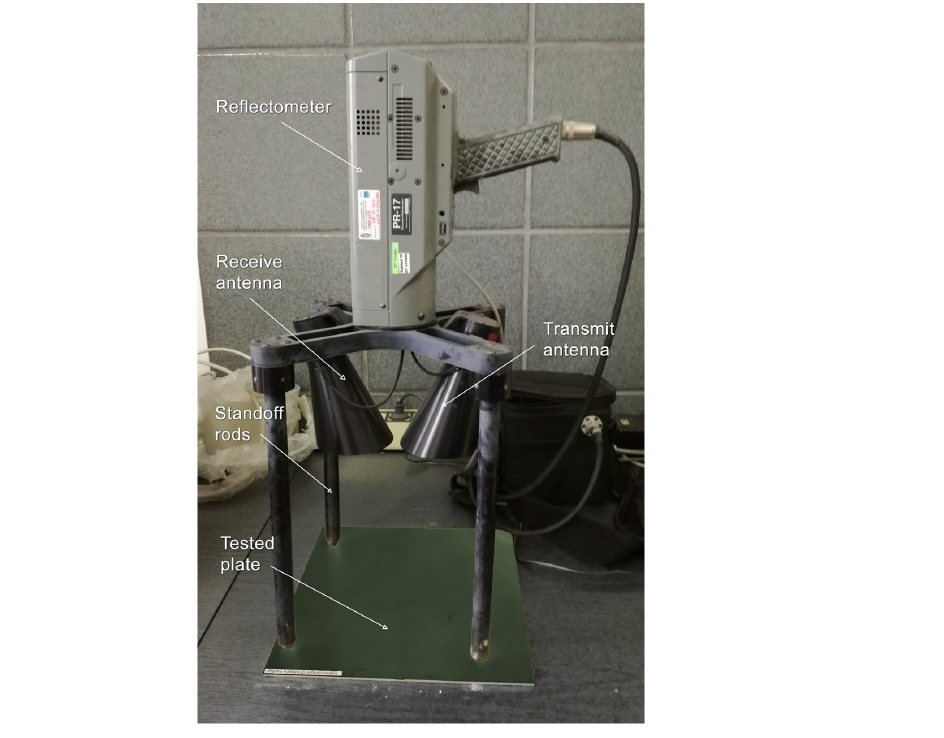
Figure 2. Scheme of the testing setup.